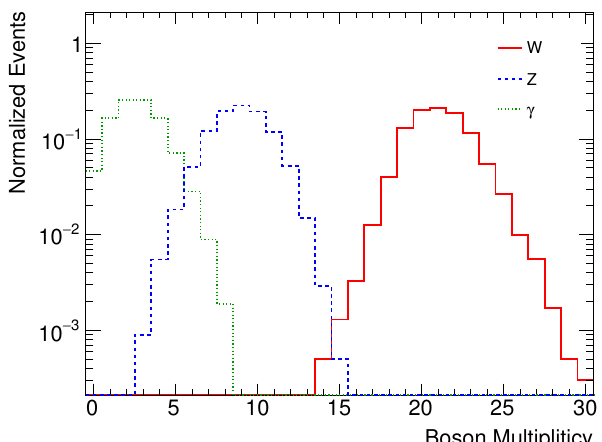
Figure 1 . Normalised distributions of the number of W , Z and (cid:13) generated by HERBVI . The event samples for zero- and multi-boson (cid:12)nal states are generated by BaryoGEN [43] and HERBVI [26], respectively, for pp collisions at centre-of-mass energy BaryoGEN only generates partonic (cid:12)nal states from the hard process, the sample is passed to Pythia 8 [45] to simulate the parton shower and hadronization. HERBVI is a hard process generator interfaced to the Fortran HERWIG generator [46]. For this study we use the last Fortran version HERWIG 6.521